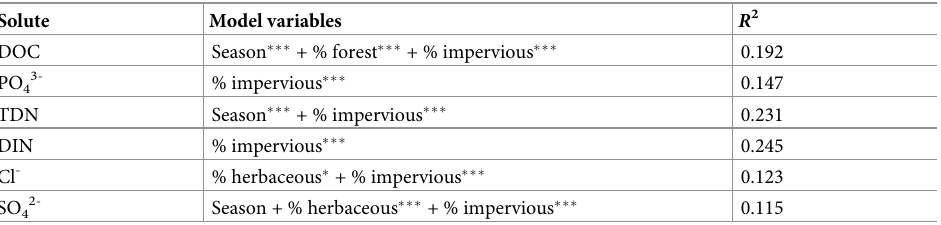
Table 2. Multiple linear regression models of solute concentration by land use and Season.